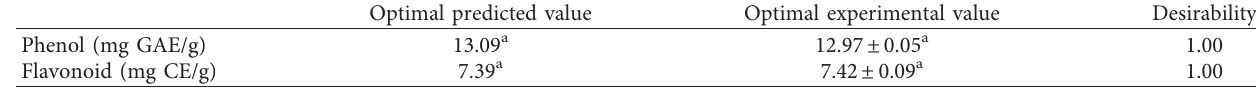
Table 6: Experimental, predicted values, and desirability for TPC and TFC in optimal conditions.